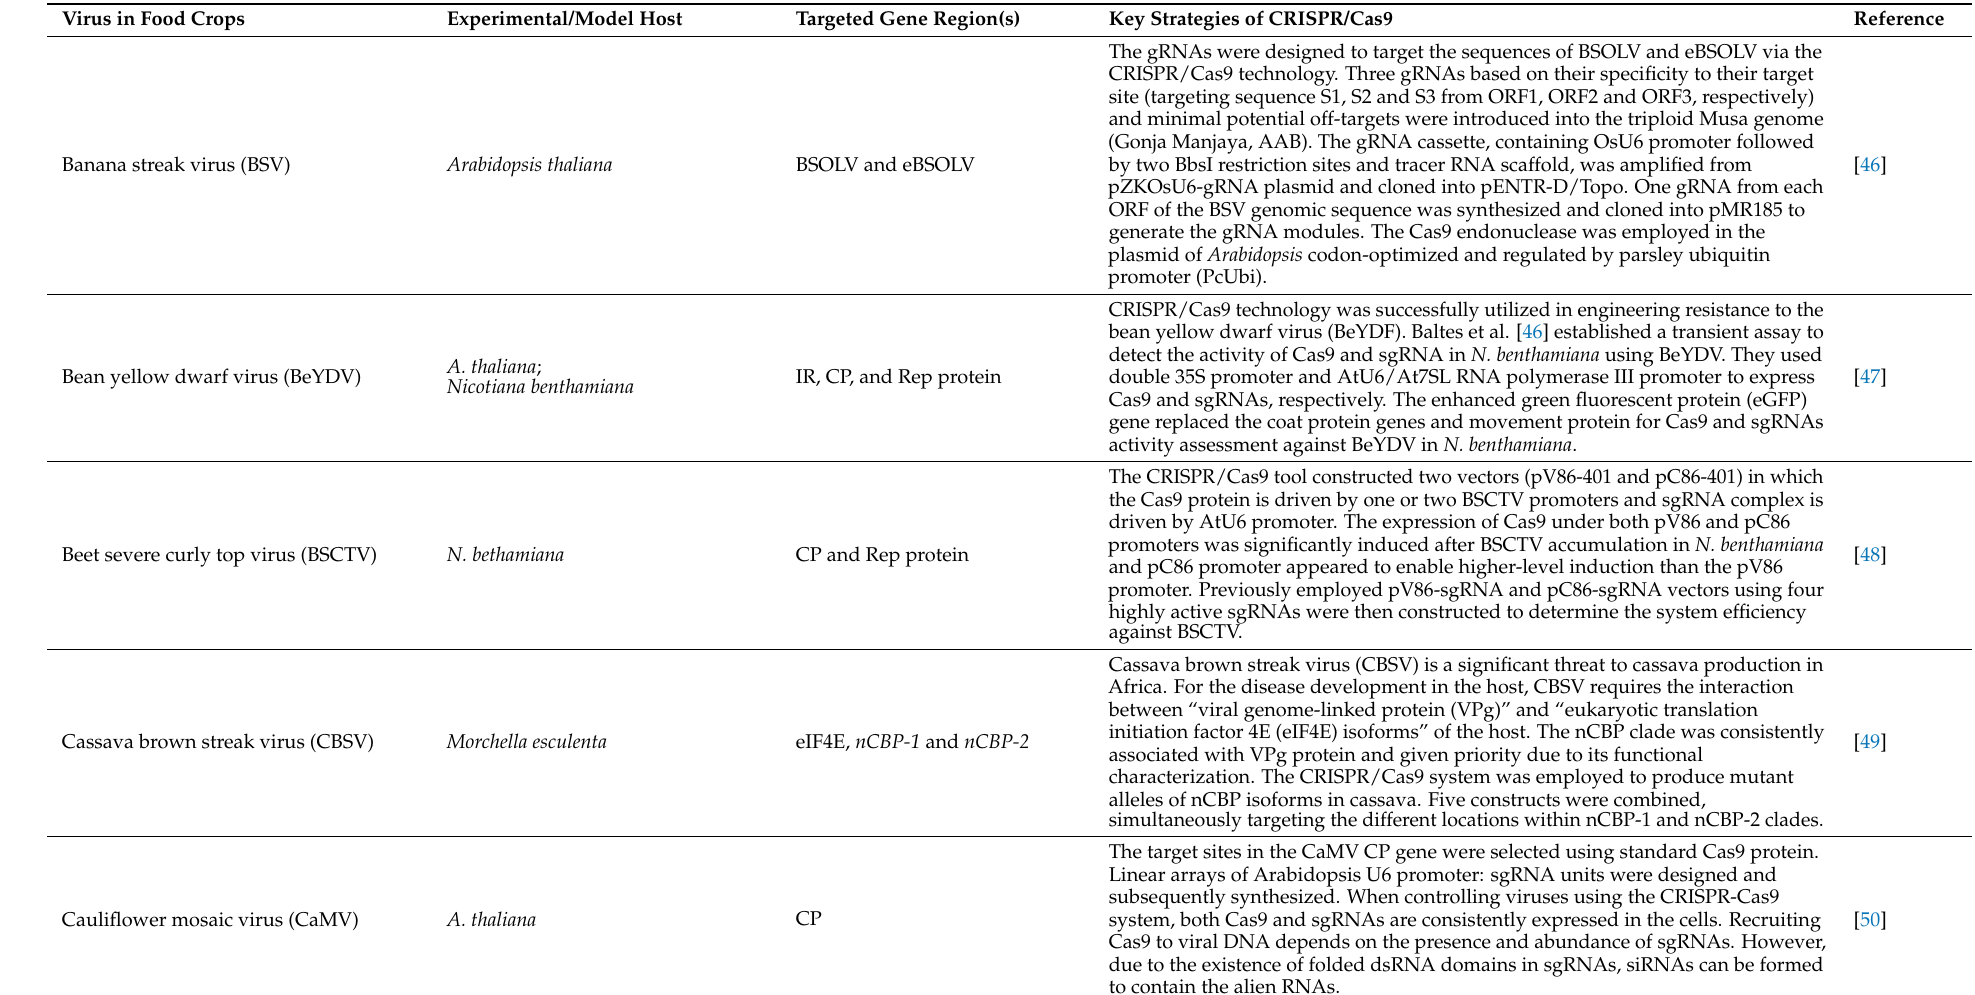
Table 2. A meta-analysis of CRISPR/Cas9 strategies used for virus resistance in selected food crops; data summarized from 2015–2021 published